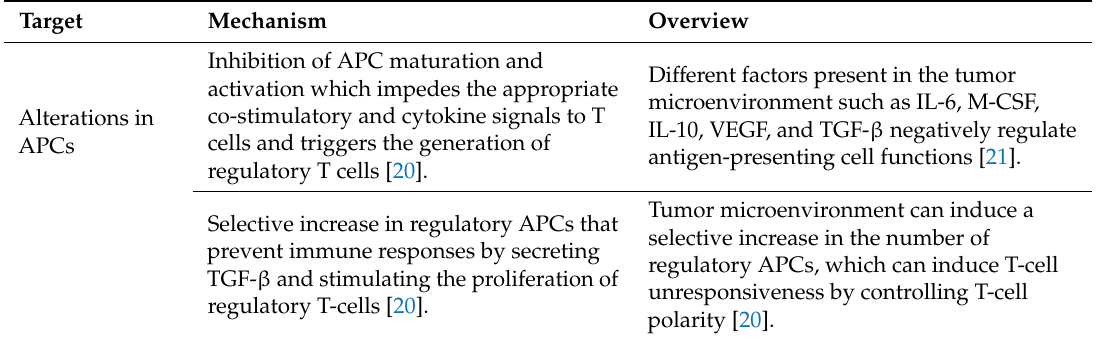
Table 2. Immune system mechanisms of tumor